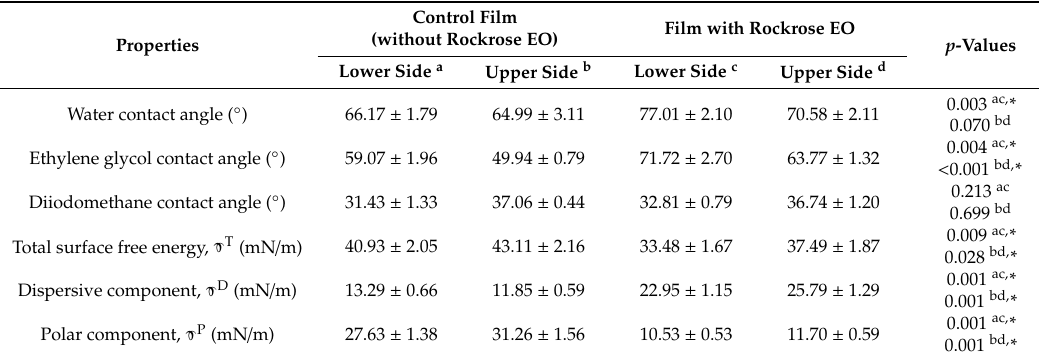
Table 6. Contact angles and surface free energy